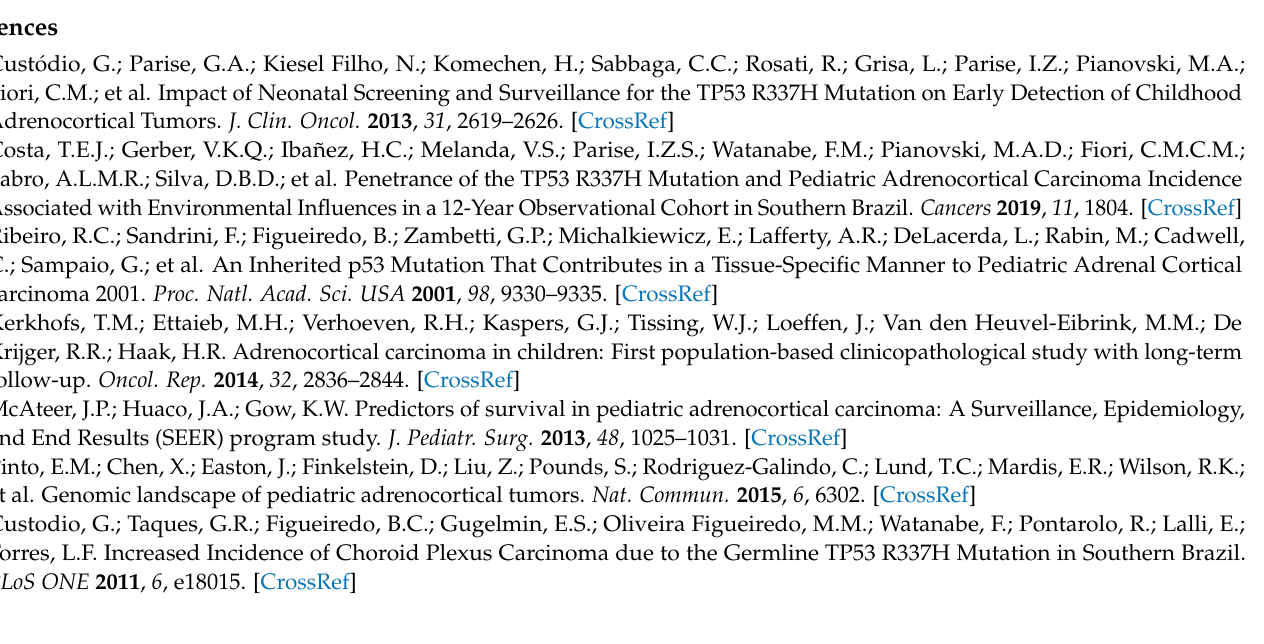
Table S1: Features at diagnosis of children with ACT in newborn screening, but not surveillance; Table S2: Analysis of tumor weight according to newborn screening and surveillance; Table S3: Analysis of disease stage according to newborn screening and surveillance; Table S4: Analysis of duration of symptoms according to newborn screening and surveillance; Table S5: Cost with chemotherapy or surgery for patients with advanced-stage